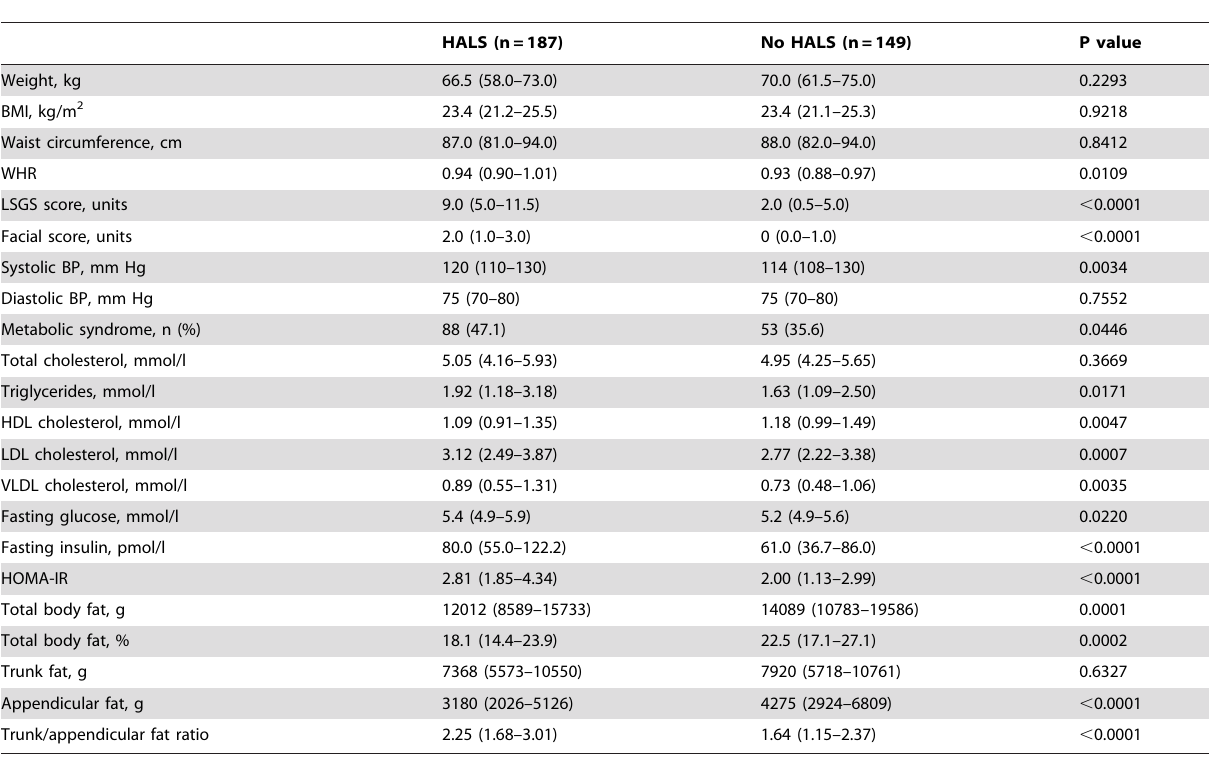
Table 3. Anthropometric, metabolic and fat data in d4T-exposed